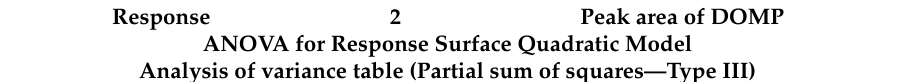
Table 7. ANOVA for response surface for peak area of